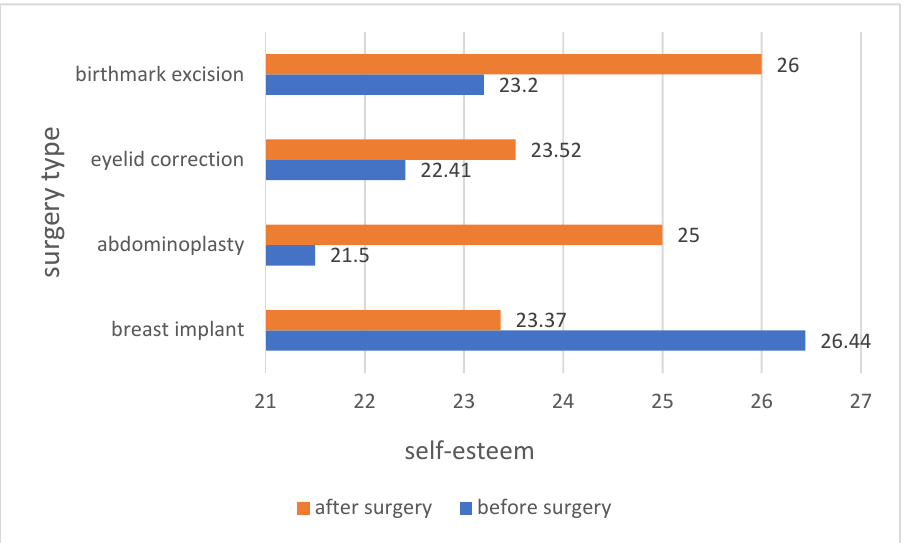
Figure 6. Comparison of patients’ self-esteem before and after a specific type of surgery.